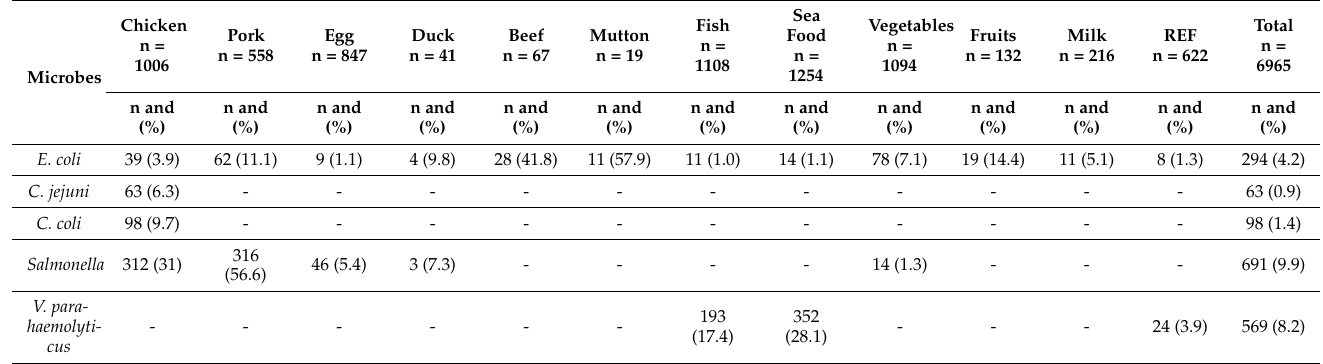
Table 1. Food product categories along with microbes that have been detected in China from 2012 to 2021, where n = total number of food samples contaminated; % of